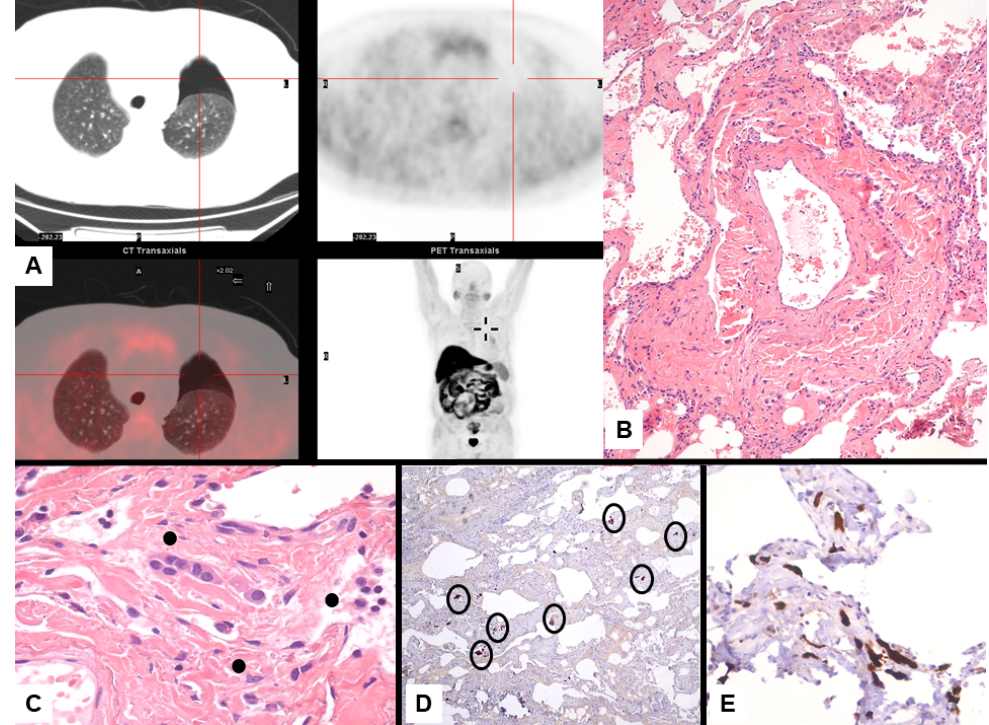
Figure 3. Mesothelioma presenting with left pneumothorax at imaging study with PET/CT scan without evidence of pleural thickening ( A ). Lung resection of the left apex shows interstitial fibrosis with tiny, scattered, bland-looking proliferation of epithelioid cells ( B ) partially lining alveoli and merging in the fibrosis ( C , dots). Calretinin staining highlights the mesothelial differentiation of epithelioid cell nests randomly scattered through the lung parenchyma ( D , circles) lining the alveolar spaces ( E ).